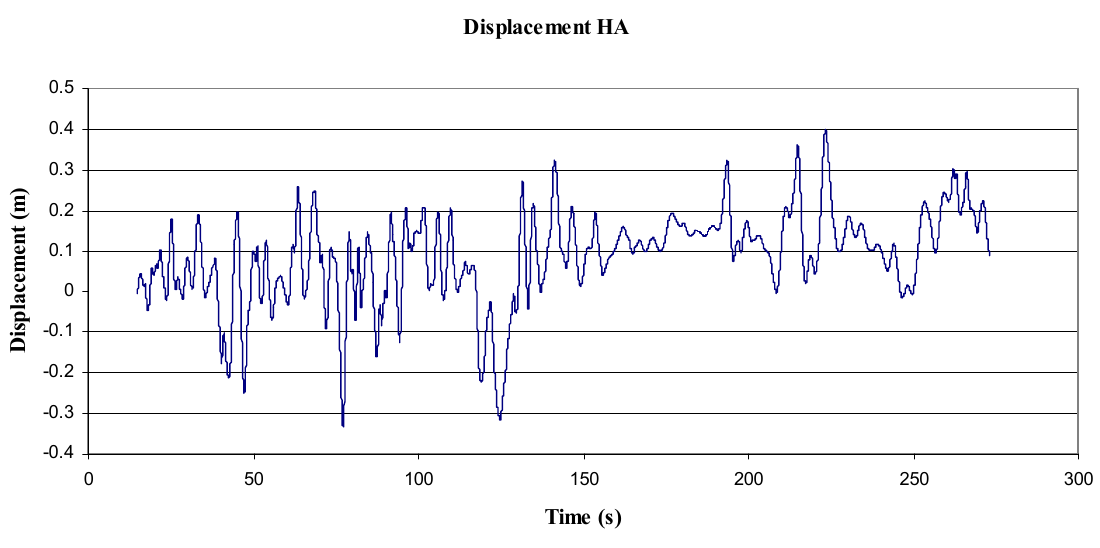
) from acceleration in axis HA, for inertial MOV